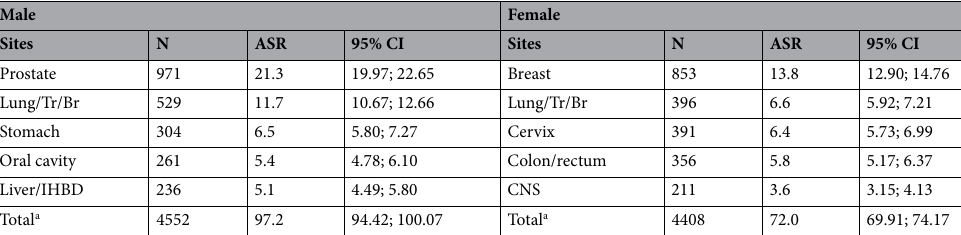
Table 3. Number of cases of the leading causes of cancer deaths (N), with respective age-standardized mortality rates (ASR) per 100,000 men and women and 95% confidence intervals (95% CI) in Sergipe, 2014–2018. ASR age-standardized rate (world population), CI Confidence interval, Br bronchus, Tr trachea, CNS Central nervous system, IHBD Intrahepatic bile ducts. a All cancer deaths, except NMSC.